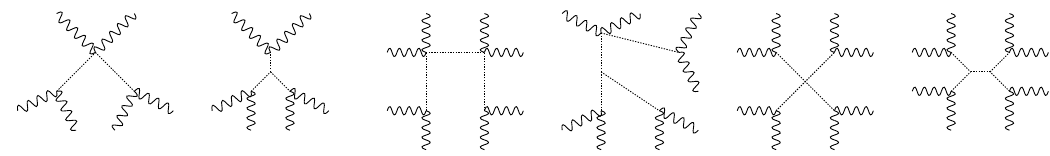
Figure 3 . Representative Feynman diagrams for the Z 6 demonstrating the dependence on the trilinear and quartic Higgs